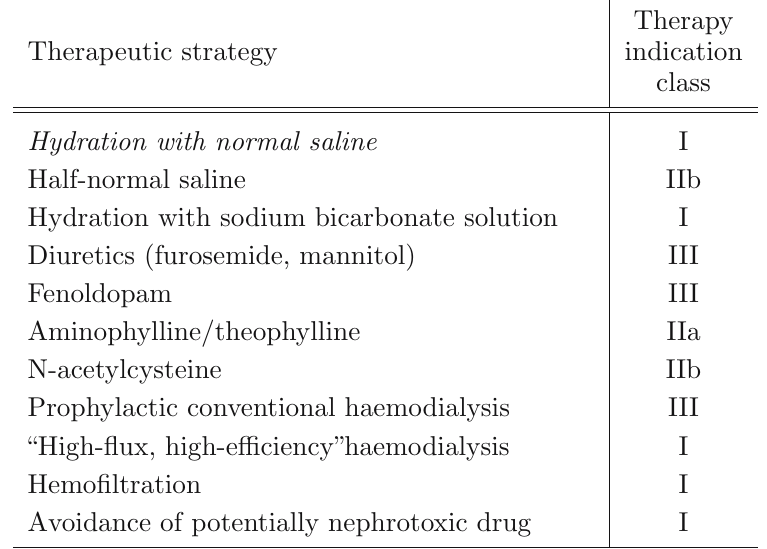
Table 6 Current strategies in the prevention of radiocontrast-induced nephropathy (ac- cording to evidence-based